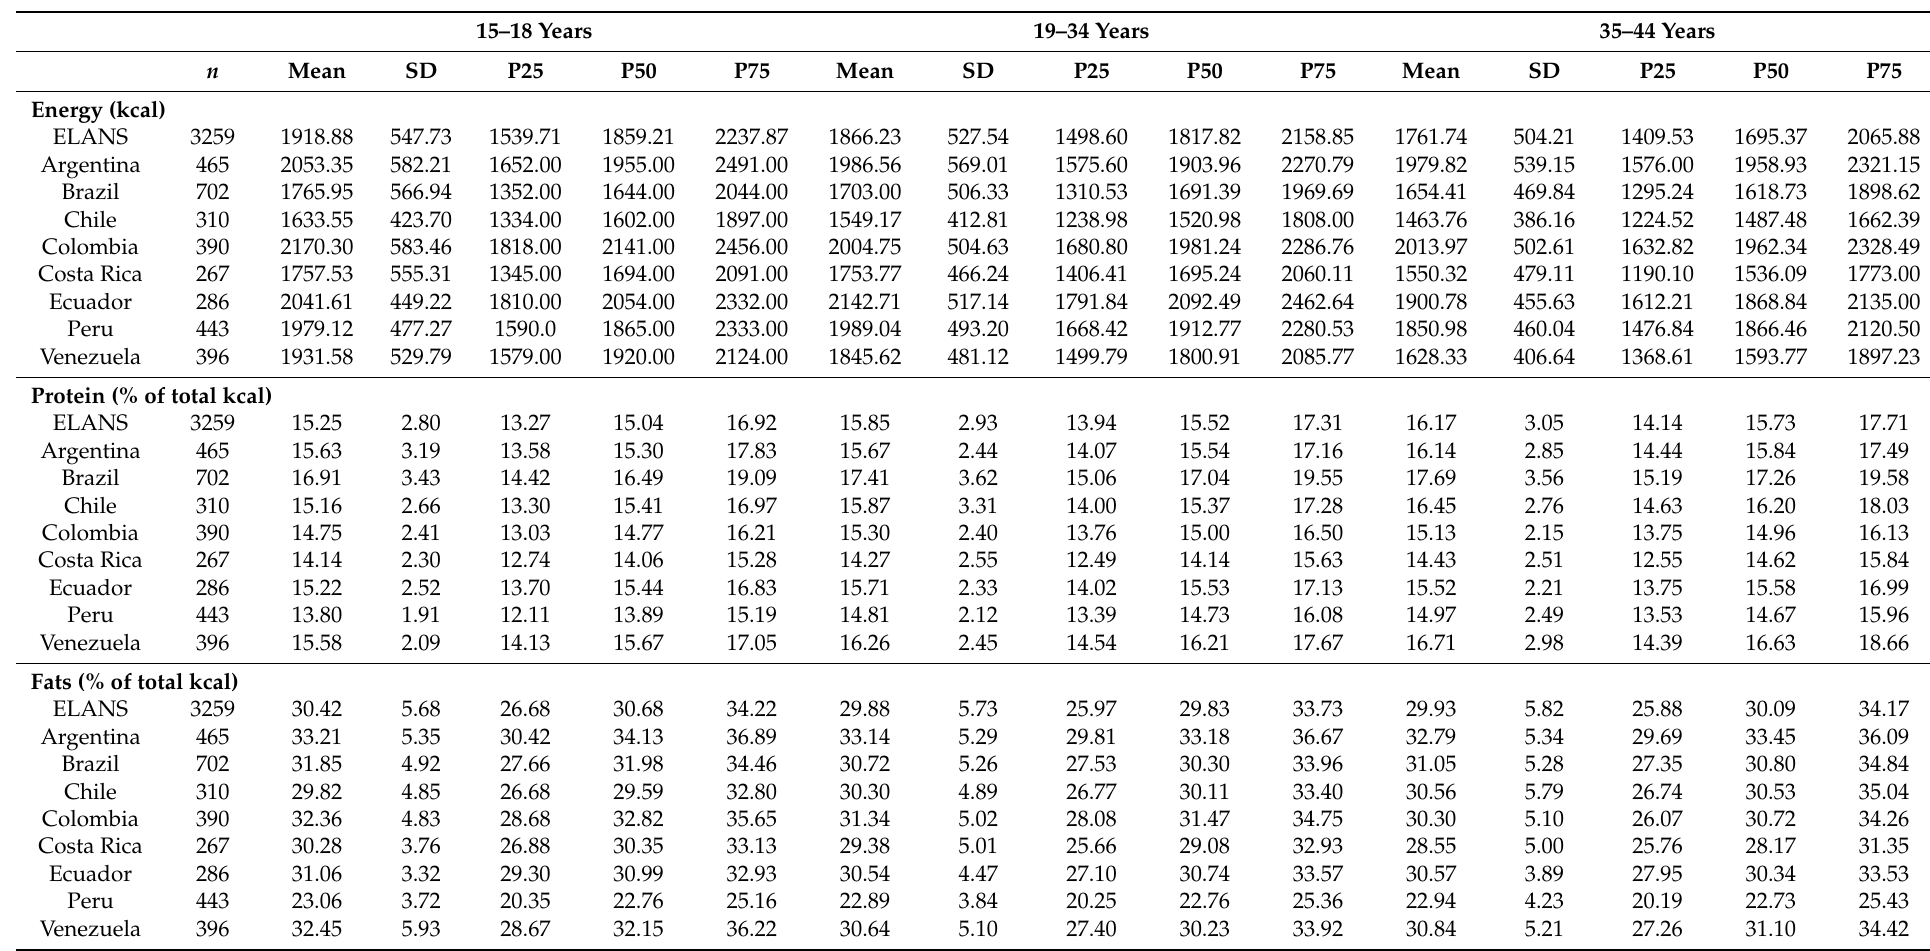
Table 4. Energy and macronutrient intake by age group and country among childbearing-age women in the Latin American Study of Nutrition and Health (ELANS),